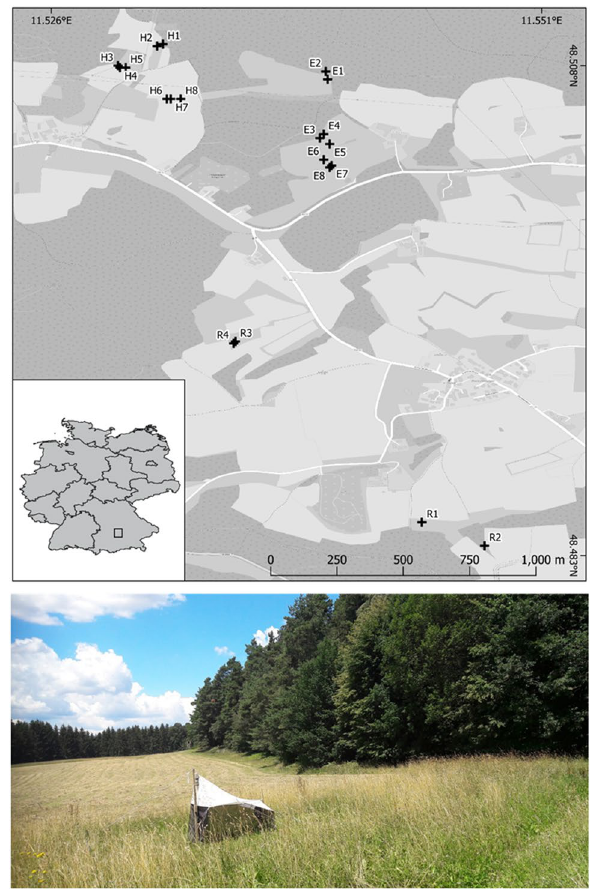
Figure 3. Study area in southern Germany (small inlet map), and locations of the 20 Malaise traps set across the agricultural landscape. Indicated are agricultural fields (light grey), meadows (grey), forest (dark grey), and settlement area. One of our Malaise traps is shown on the picture below. The map was reproduced from the OpenTopoMap web site (https:// opent opomap. org) under creative common licence CC BY-SA 3.0 (https:// creat iveco mmons. org/ licen ses/ by- sa/3. 0/ legal code), with subsequent highlighting of the study area. Photographs were taken by